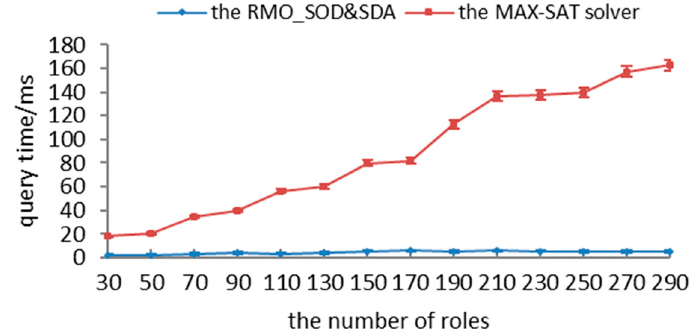
Figure 3. Query comparison when match = max.